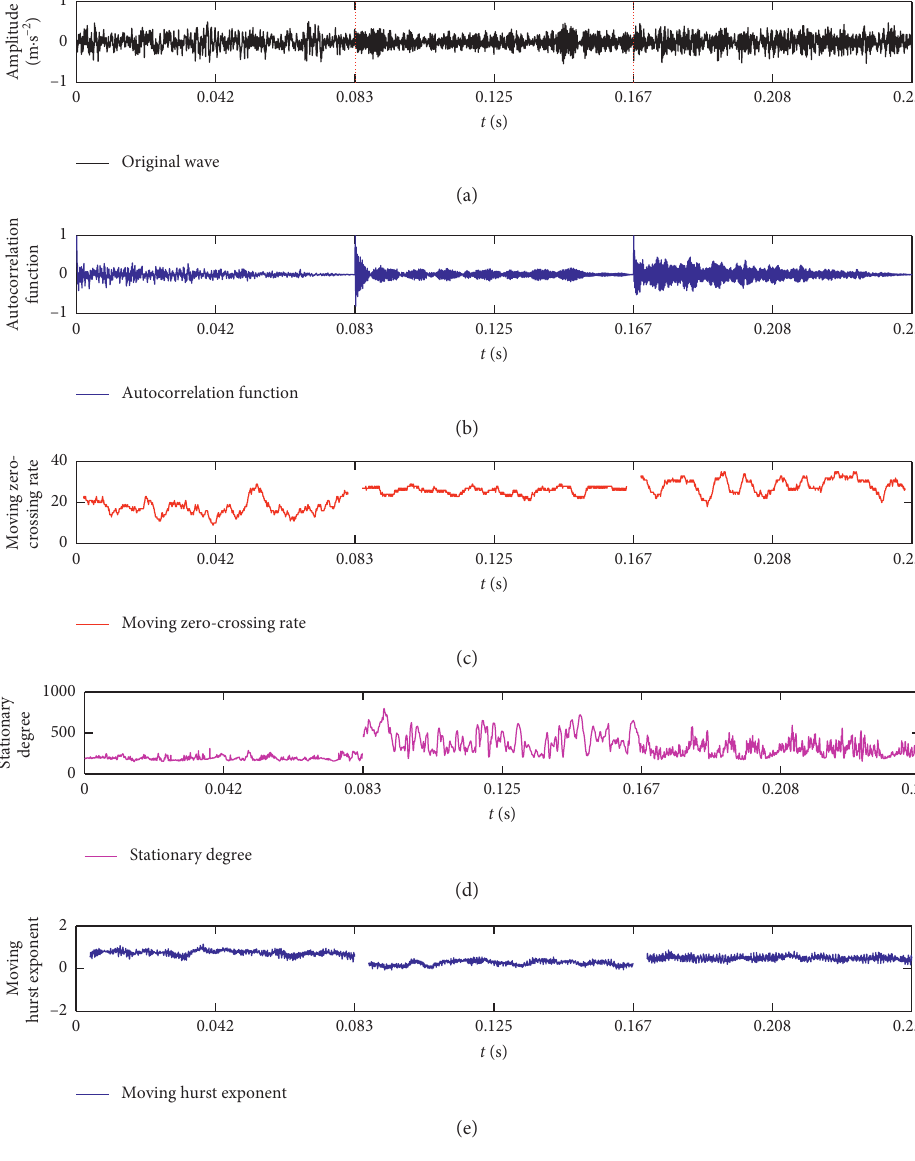
Figure 4: Analysis of mechanical fault signals based on typical